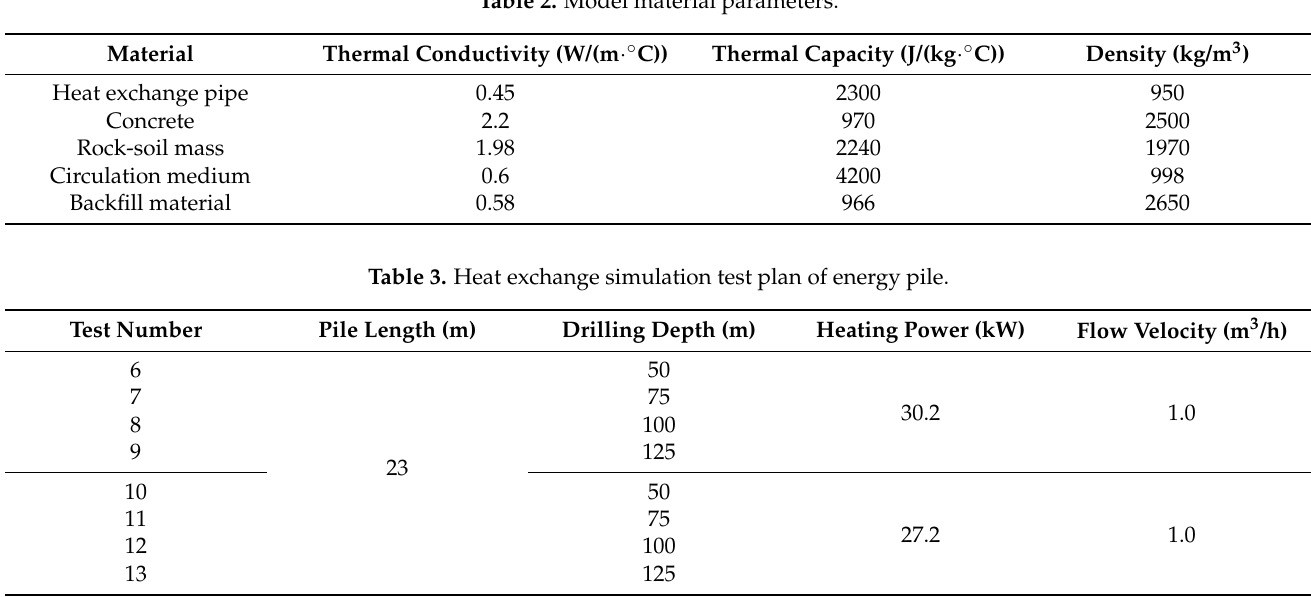
Table 2. Model material parameters.